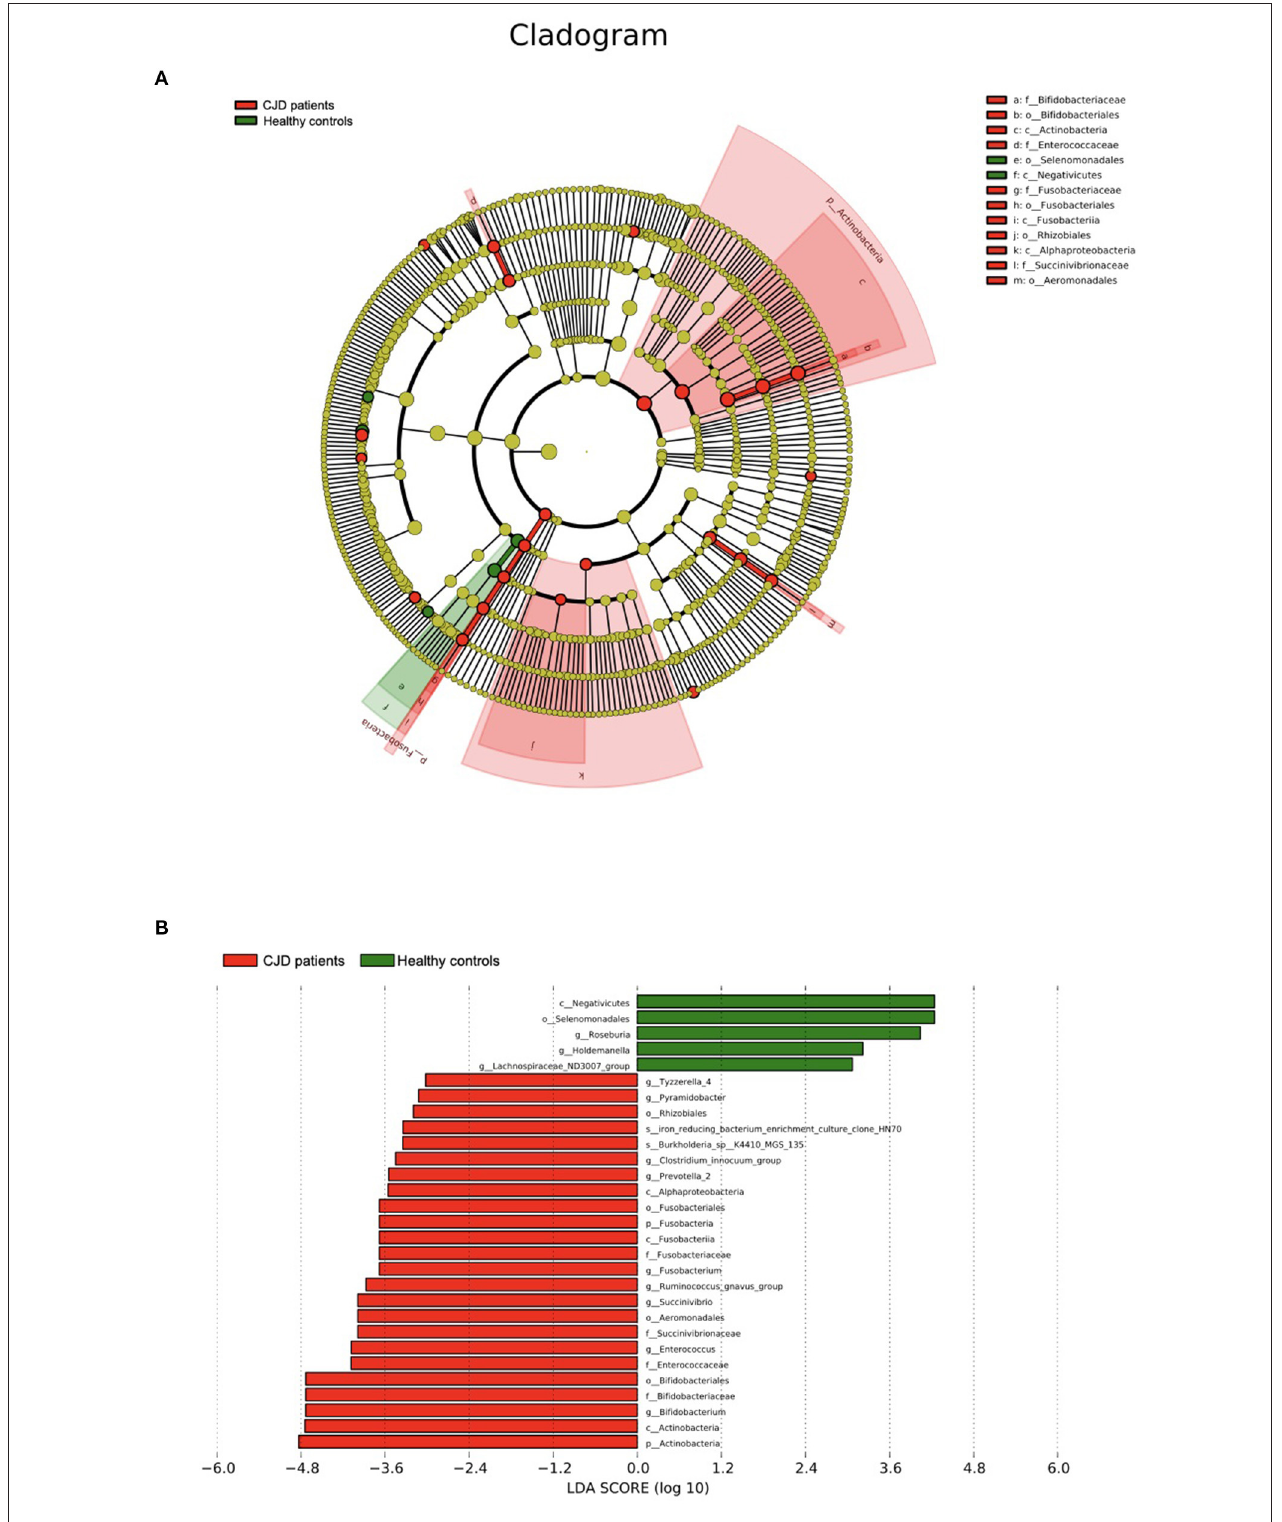
FIGURE 3 | Results of the LEfSe using Python (V2.7). (A) The outer ring to the inner ring of the cladogram represents the biological taxonomy from phyla to genus. Each dot in the ring represents a microbiota in the corresponding taxonomy level, and the diameter of each dot is proportional to the taxon’s abundance. The color of each dot represents the difference in the abundance in the corresponding microbiota between patients with CJD and controls. Yellow indicates the difference in the